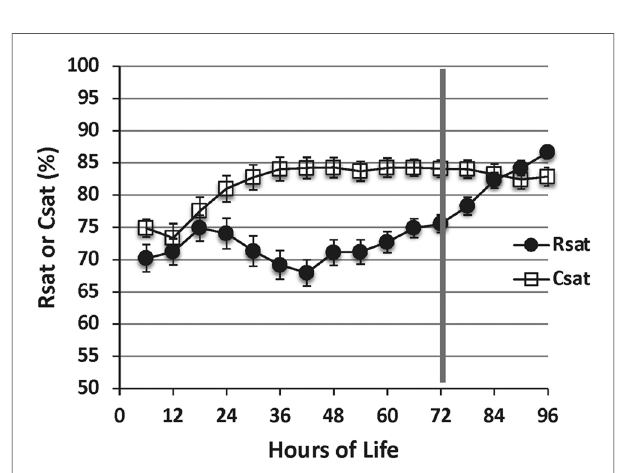
FIGURE 6 Cerebral saturation (csat) Is higher during the cooling period compared with renal saturation (rsat) ( p <.01). After rewarming at 72 h, cerebral saturation decreases While renal saturation increases (reproduced with permission from Chock VY, Frymoyer A, Yeh CG, Van Meurs KP. Renal Saturation and Acute Kidney Injury in Neonates with Hypoxic Ischemic Encephalopathy Undergoing Therapeutic Hypothermia. J Pediatr.